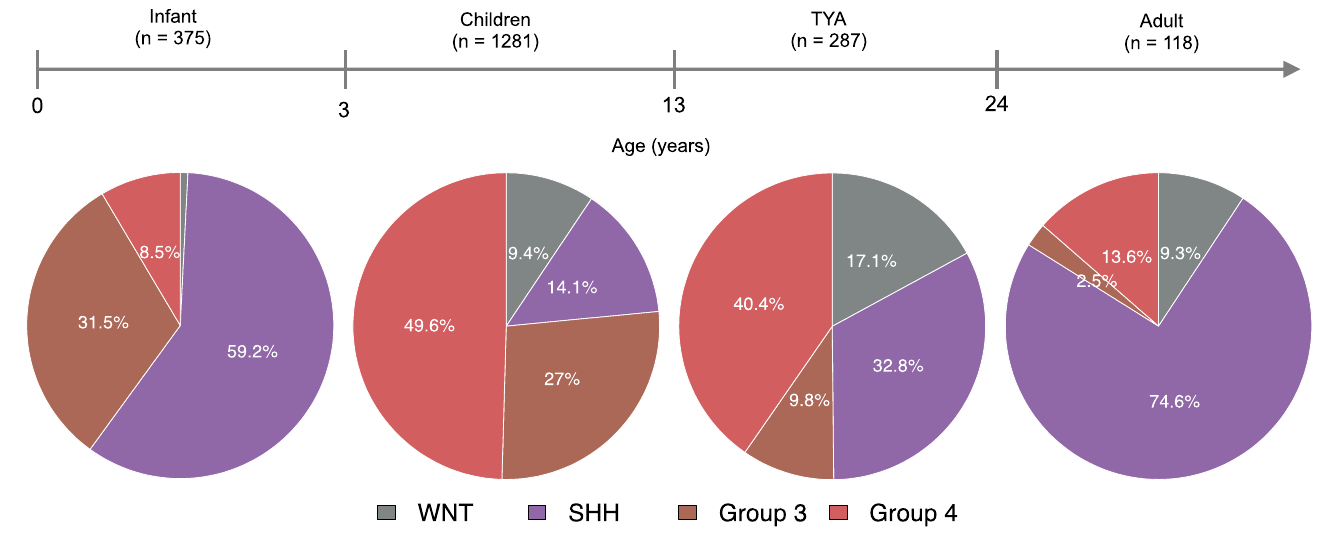
Figure 1. Comparative analysis of medulloblastoma patients by age and molecular subgroups. Four pie charts describing the distribution of molecular subgroups for medulloblastomas by age group: (1) Infant (<3 years), (2) Children (4–12 years), (3) Teenager and young adult, TYA (13–24 years), and (4) Adult (>24 years). Molecular subgroup and age data were collected from published studies that resulted in a total of 2061 medulloblastoma patients.